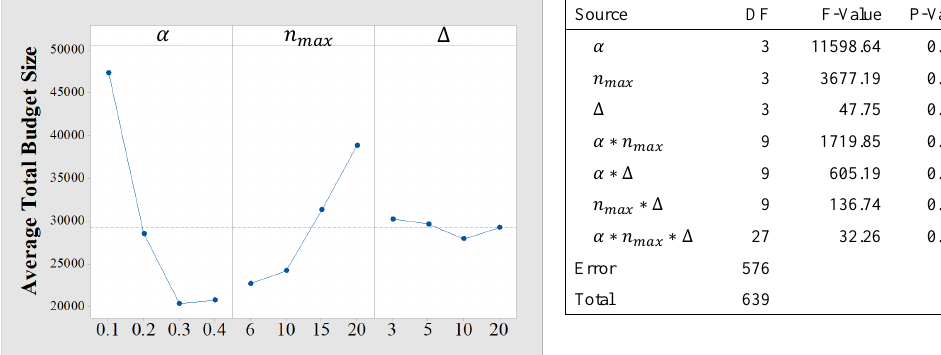
Figure 4. The main effect plot and the ANOVA table for Problem F5(2D). A total of 500 replications are executed and divided into 10 batches. The Box–Cox transformation is performed, and R 2